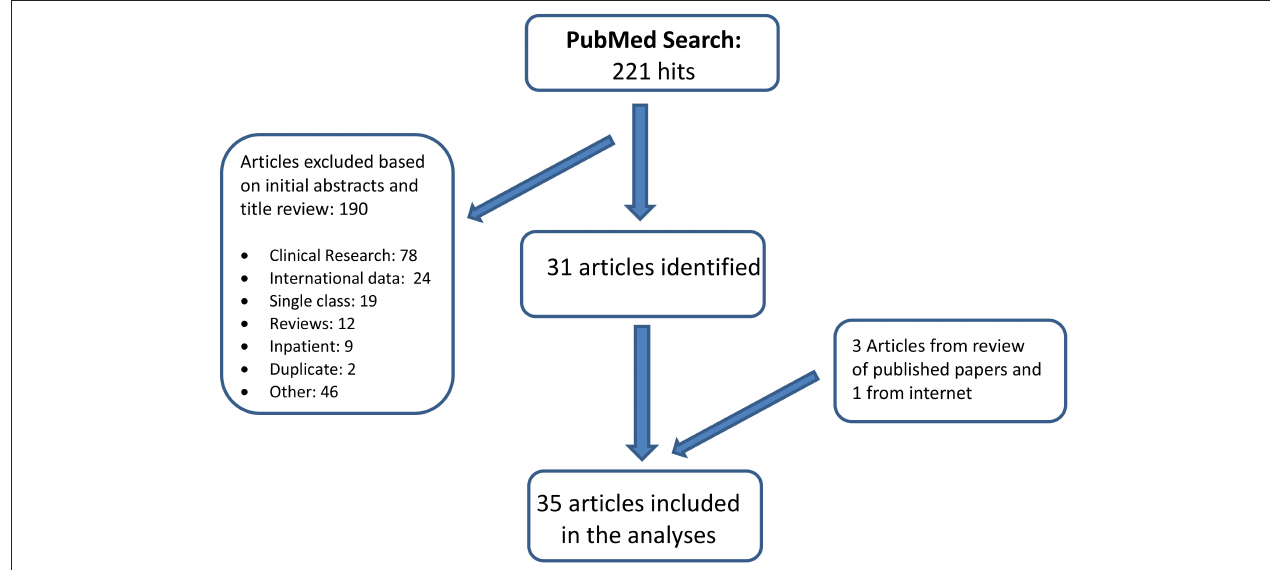
FIGURE 1 | Flow chart of the review process.